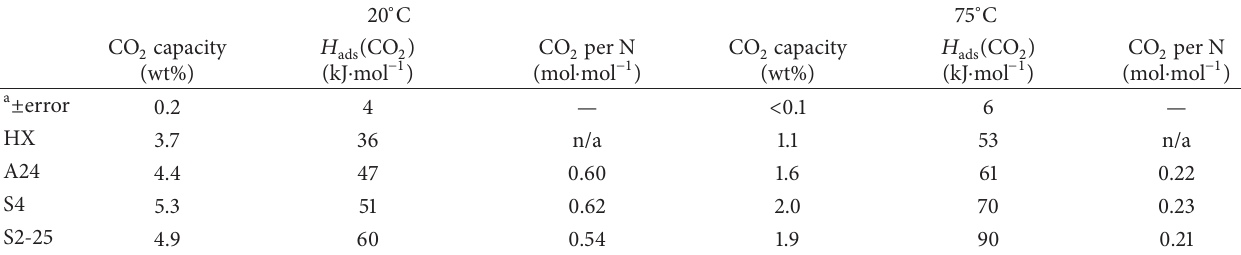
Table 2: Product CO 2 adsorption capacities, heats of adsorption of CO 2 , and amine efficiencies.